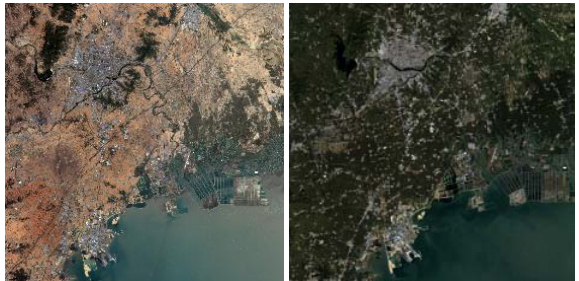
Figure 2. Thumb image of the ZY-3(01) and ZY-3(02) in the experiment (Left: ZY-3(01), right: ZY-3(02))